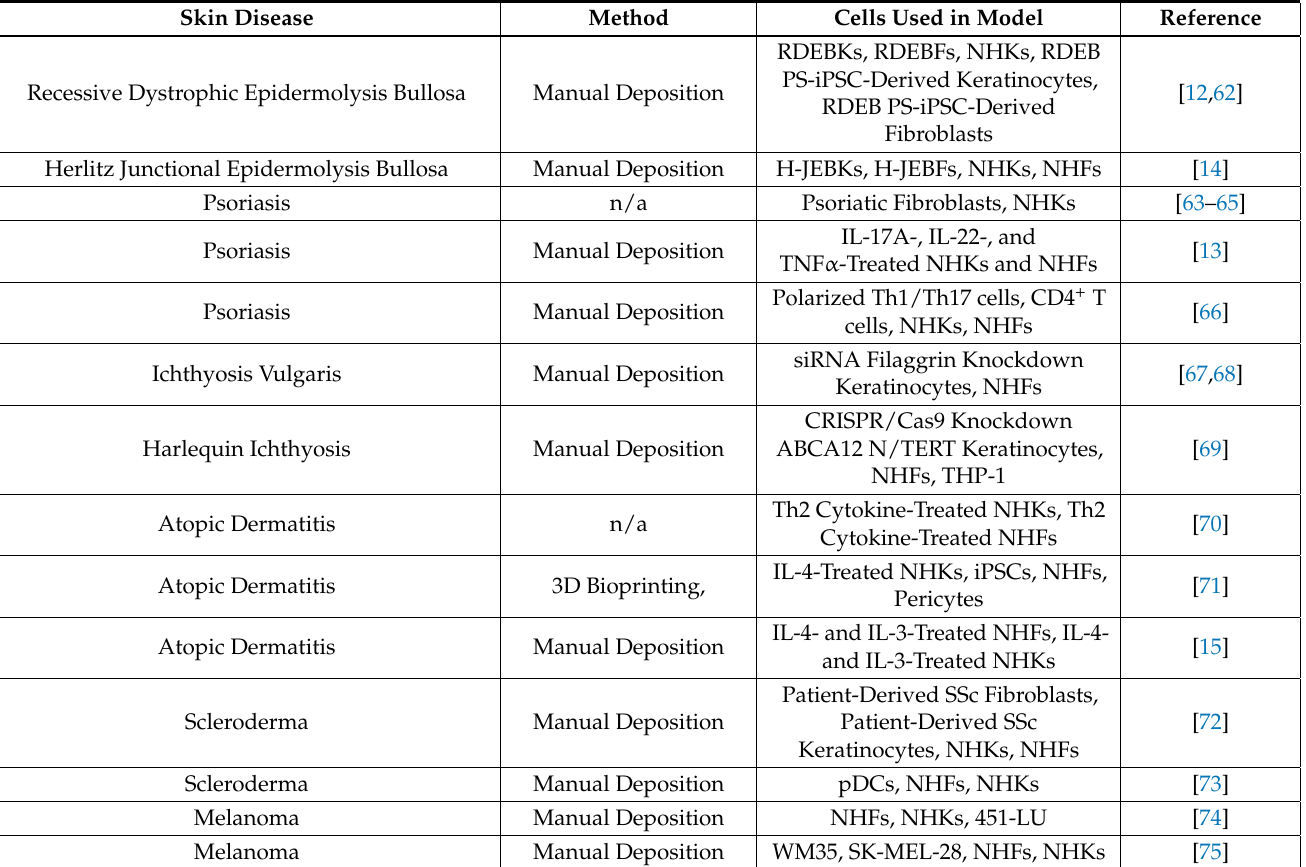
Table 1. Skin diseases that currently have 3D HSE